Question: In a single sentence, describe what this figure presents.
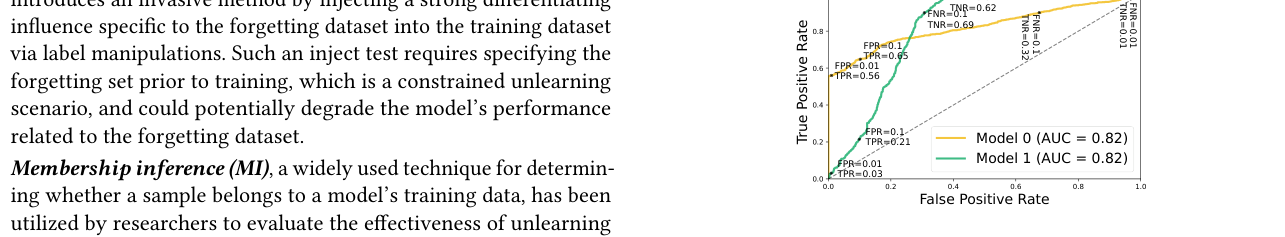
Answer: Membership Prefer vs. Non-Membership Prefer